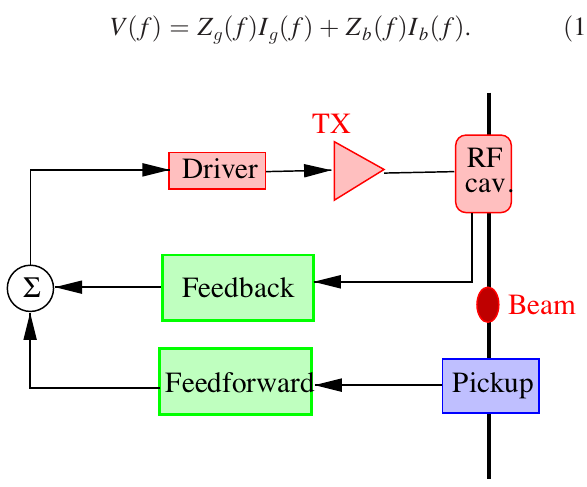
FIG. 1. SPS rf and LLRF block